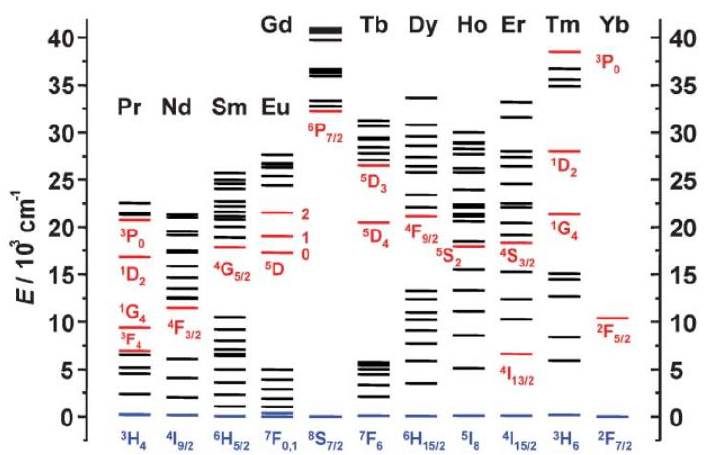
Figure 10. Partial energy diagrams for the lanthanide aquo ions. The main luminescent levels are drawn in red, while the fundamental level is indicated in blue. Reproduced from [147], with permission from RSC Publisher, 2005.